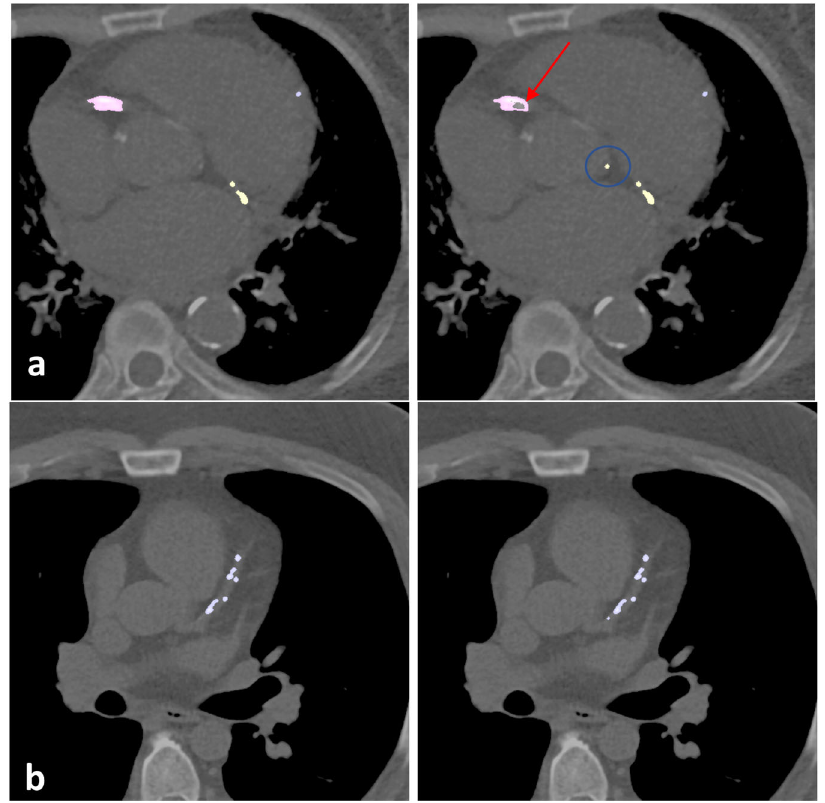
Fig. 2 Qualitative comparison between automated and manual CAC scoring. Coronary artery segmentation (manual on left; automated on right) in two different patients ( a , b ) shows qualitatively similar performance between automated and manual methods of CAC scoring. Note the false positive by model identifying coronary cusp calci fi cation (blue circle). Remainder of aortic root calci fi cation is accurately ignored by the model. Red arrow shows an area of false negative within an area of right coronary artery calci fi cation.